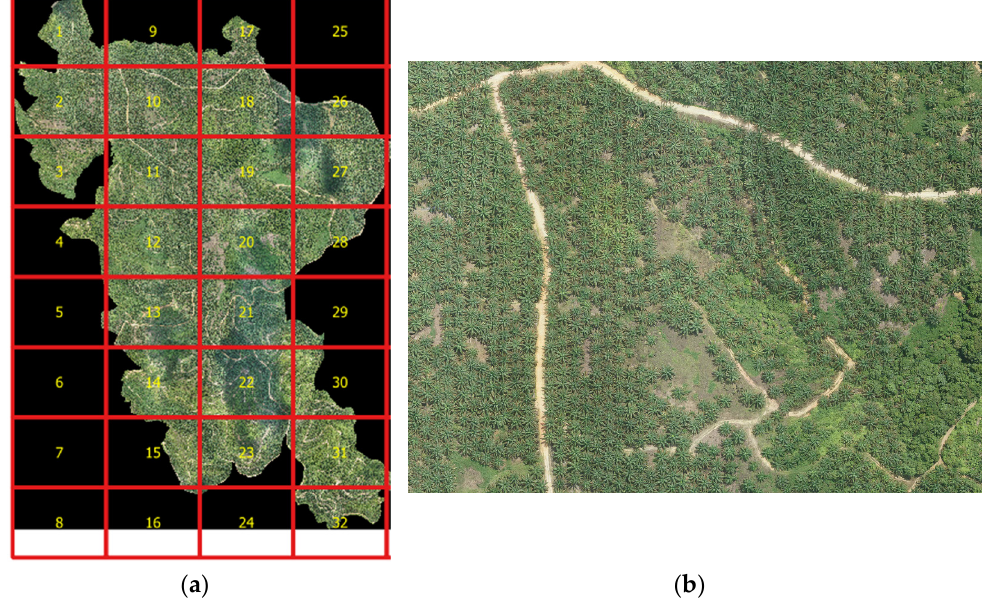
Figure 6. An example of image cropping 7886 × 5914 pixels: ( a ) Mapping on block area; ( b ) Cropping results on grid number 10. There are 24 testing areas from cropping results on the map, namely on grid numbers 1,2,3,9,10,11,12,13,14,15,17,18,19,20,21,22,23,26,27,28,29,30,31,32.